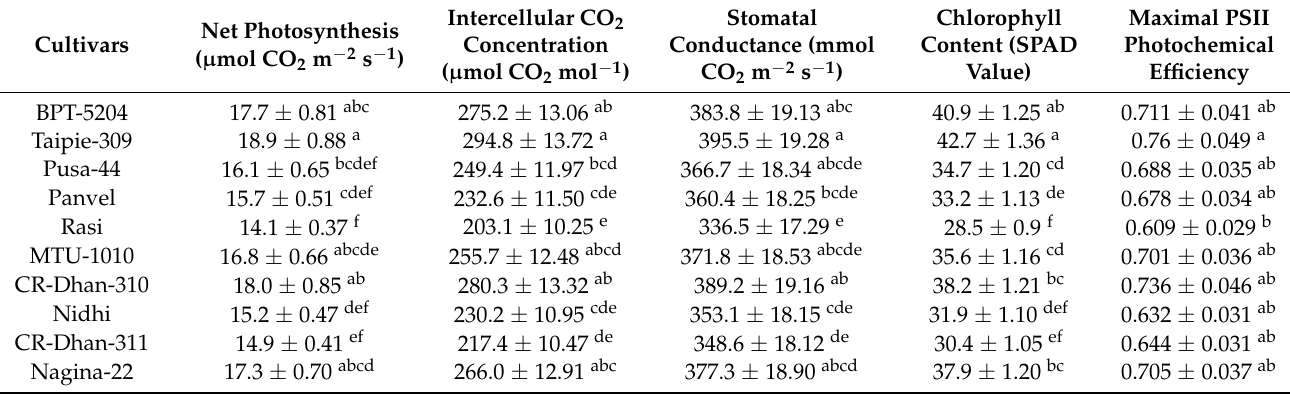
Table 2. Net photosynthesis, intercellular CO 2 concentration, stomatal conductance, chlorophyll content (SPAD value) and maximal PSII photochemical efficiency in cultivars of rice ( Oryza sativa L.) at 30 days after germination (DAG). Data are presented as treatments mean ± SE (n = 4). Data followed by same letter are not significantly different by LSD test at p < 0.05.